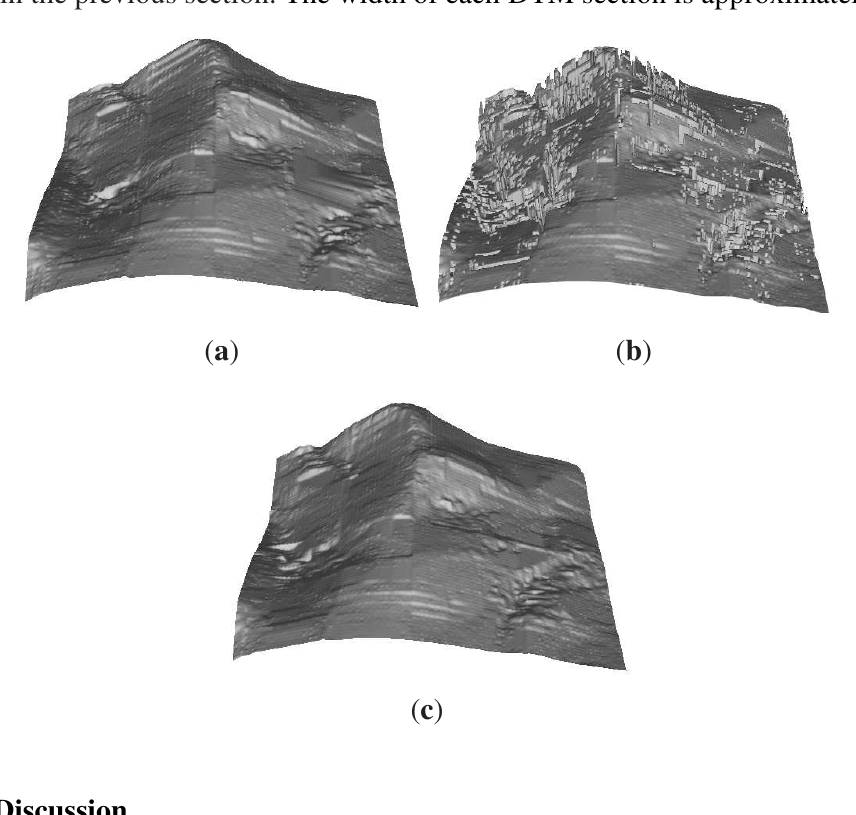
Figure 6. Detecting and repairing jumps in the DTM: (a) original DTM section; (b) locations detected as jumps marked (light spots); (c) jumps repaired using the gap-filling approach described in the previous section. The width of each DTM section is approximately 350